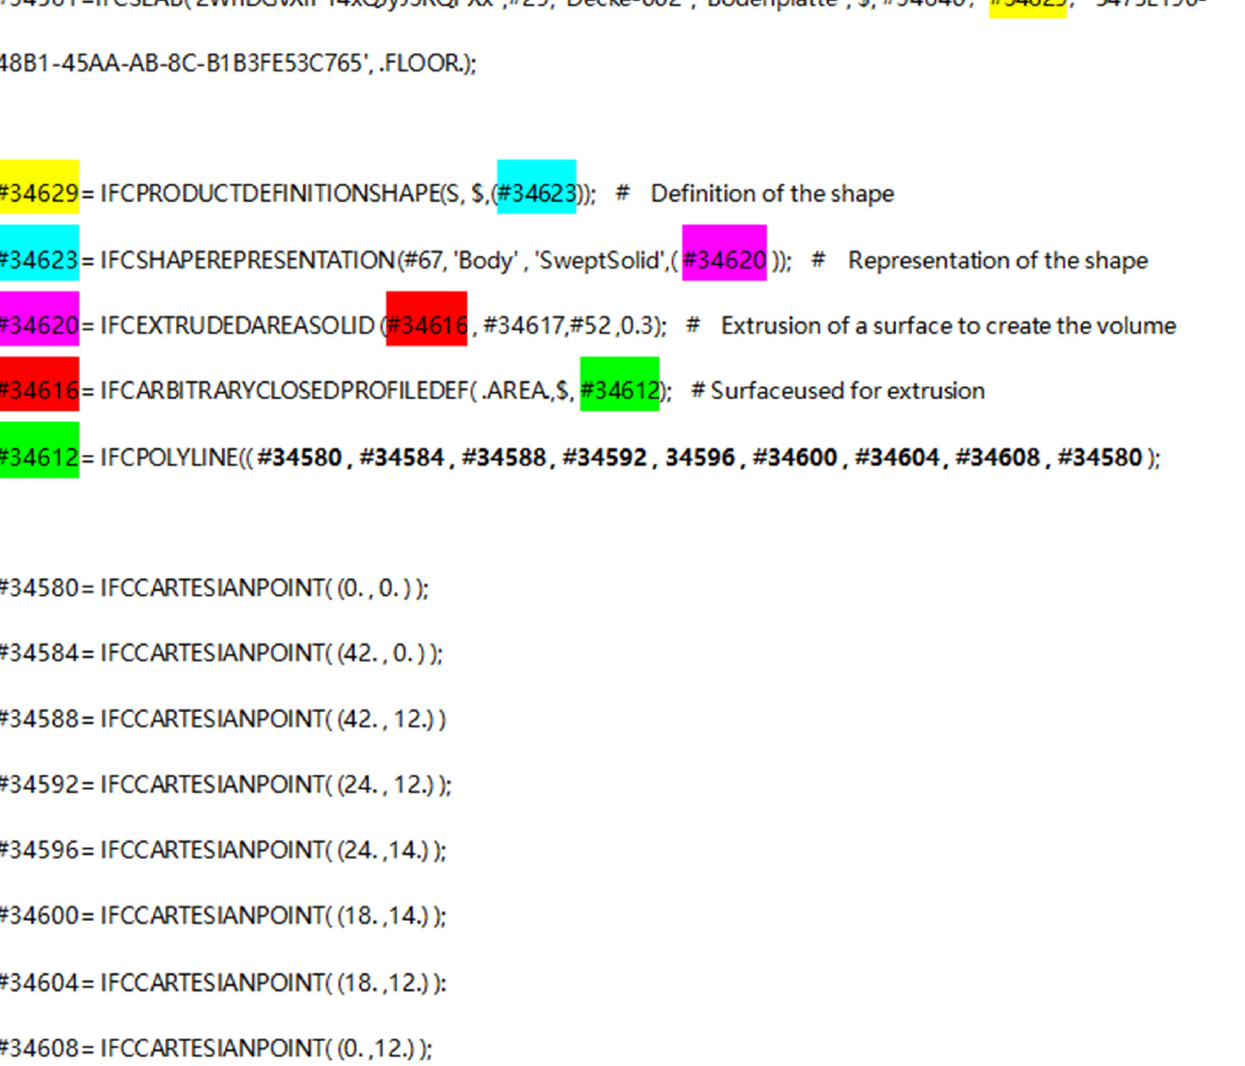
Figure 2. Data storage form of IFC files.